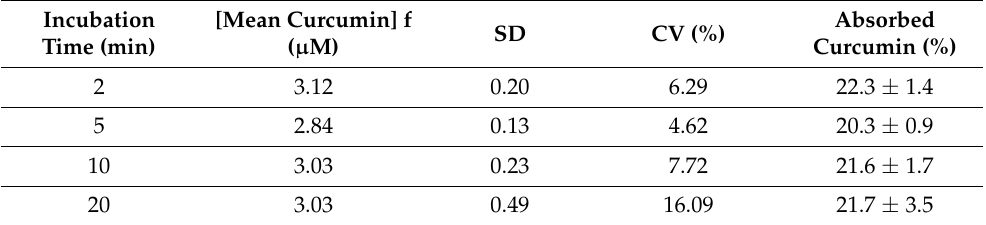
Table 1. Concentration of curcumin absorbed by one million mdMSCs after 2, 5, 10 and 20 min